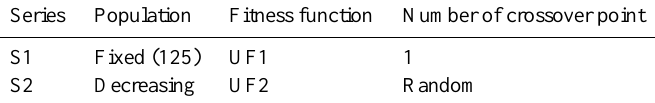
Table 1. Runned series for GA